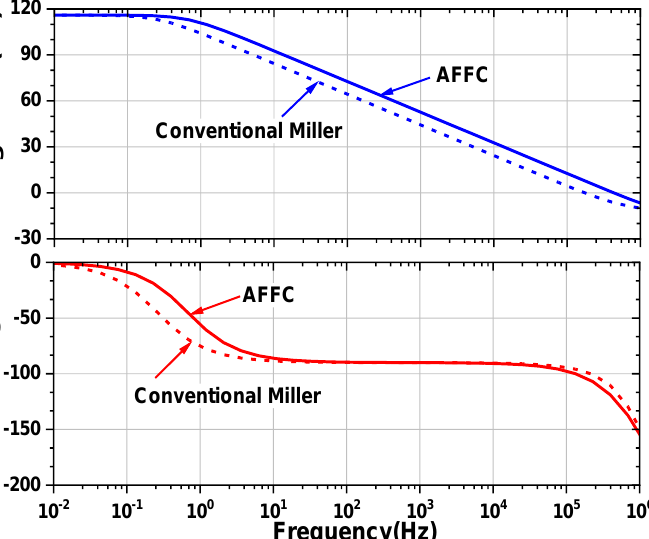
Figure 10. Comparison of the open-loop gain of the amplifier using AFFC and traditional Miller compensation.